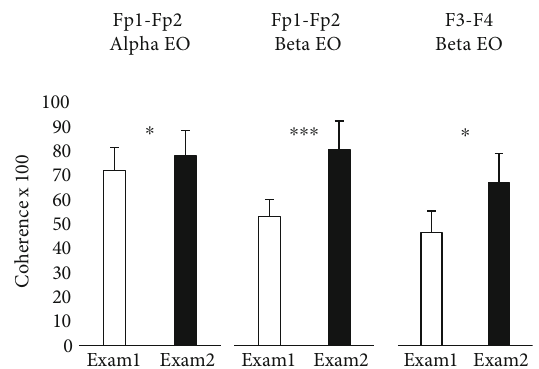
Figure 1: Frontal pole and midfrontal EEG coherences. Bars show means ± standard errors of alpha and beta coherences measured from the scalp overlying the frontal pole (Fp1-Fp2) and beta coherence measured from the scalp overlying the midfrontal cortex (F3-F4), under eyes-open (EO) conditions. Subjects were 9 healthy male medical students studied 3 d before each of their fi rst two block exams in an integrated anatomy-physiology course (Exam 1, Exam 2). ∗ indicates di ff erences signi fi cant at P < 0 : 05 , and ∗∗∗ indicates di ff erences signi fi cant at P < 0 : 001 .